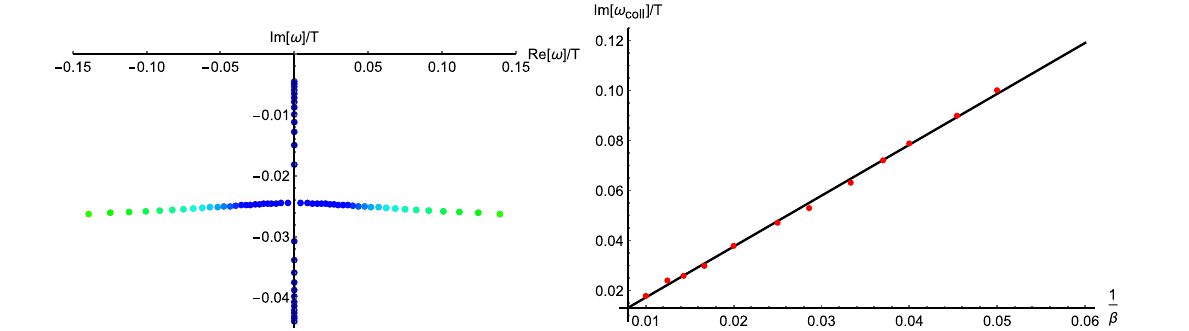
Fig. 2 Left: The motion of the lowest-lying modes on the complex plane. We fix J = 0 . 25, λ = 0 . 003125, k = 0, α/μ = 1 and dial T /μ ∈ [ 0 . 003 , 0 . 5 ] (green-blue). Right: The collision frequency as a